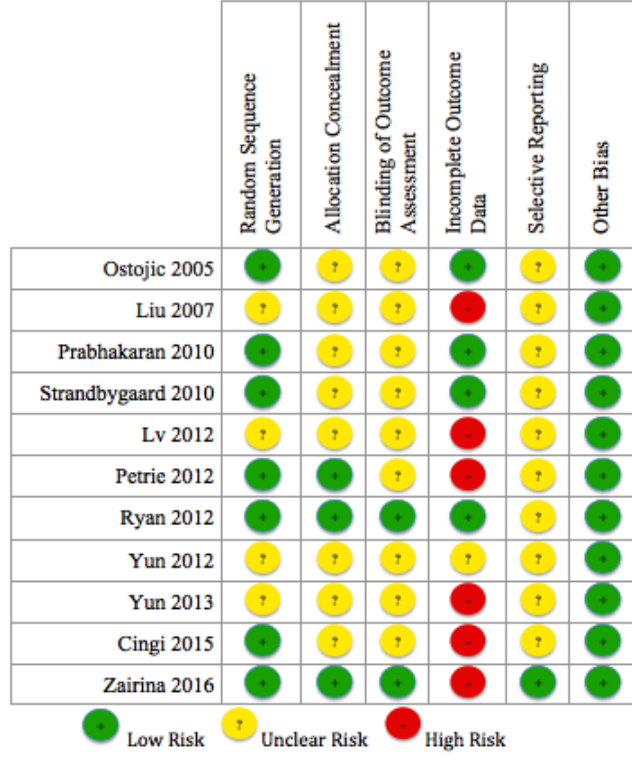
Figure 2. Cochrane risk of bias assessment: risk of bias dimension for each included